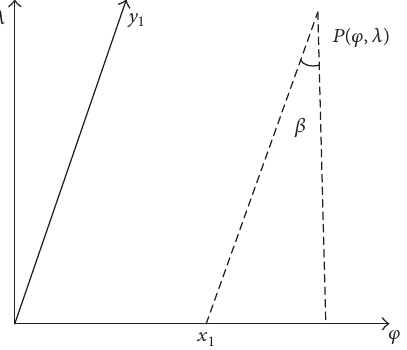
Figure 7: The oblique coordinate transformation.